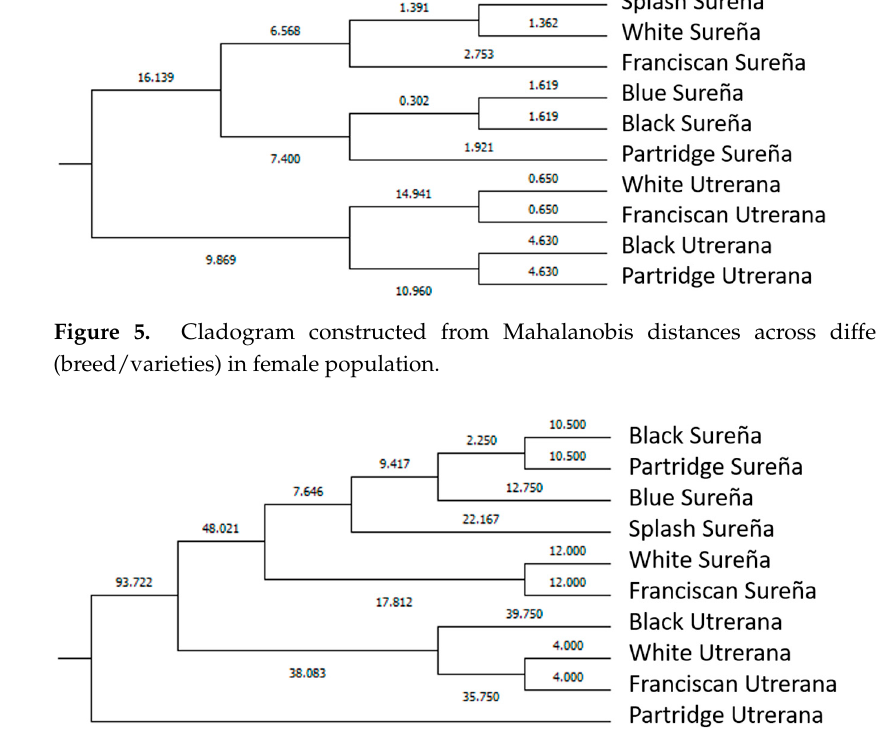
Figure 6. Cladogram constructed from Mahalanobis distances across different genotypes (breed/varieties) in male population.